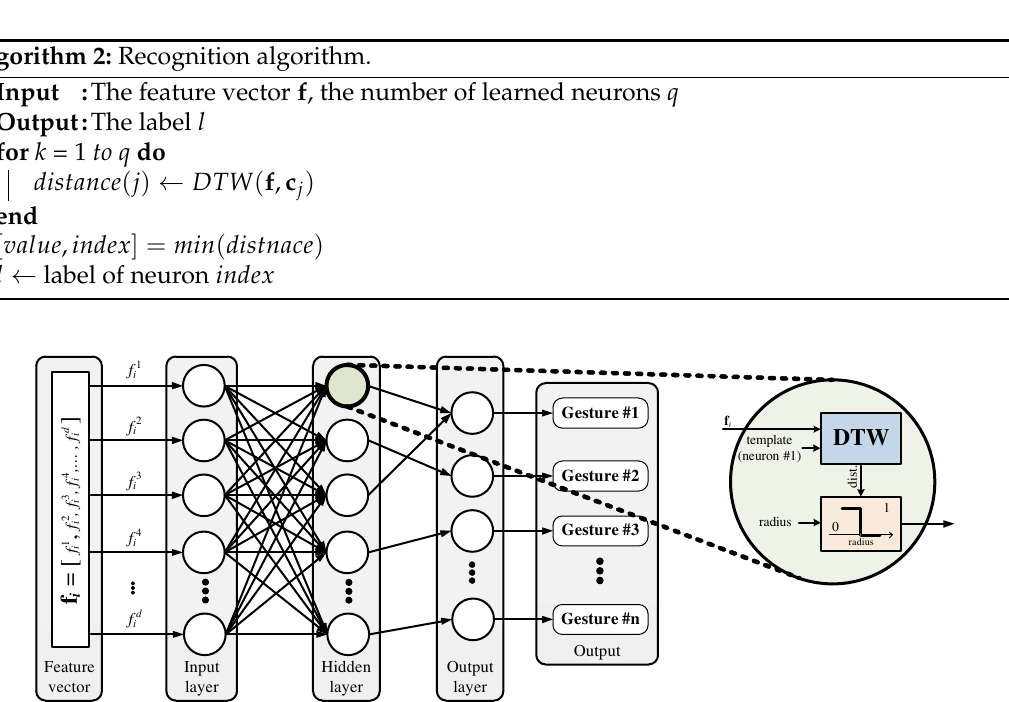
Figure 6. Structure of the proposed HGR